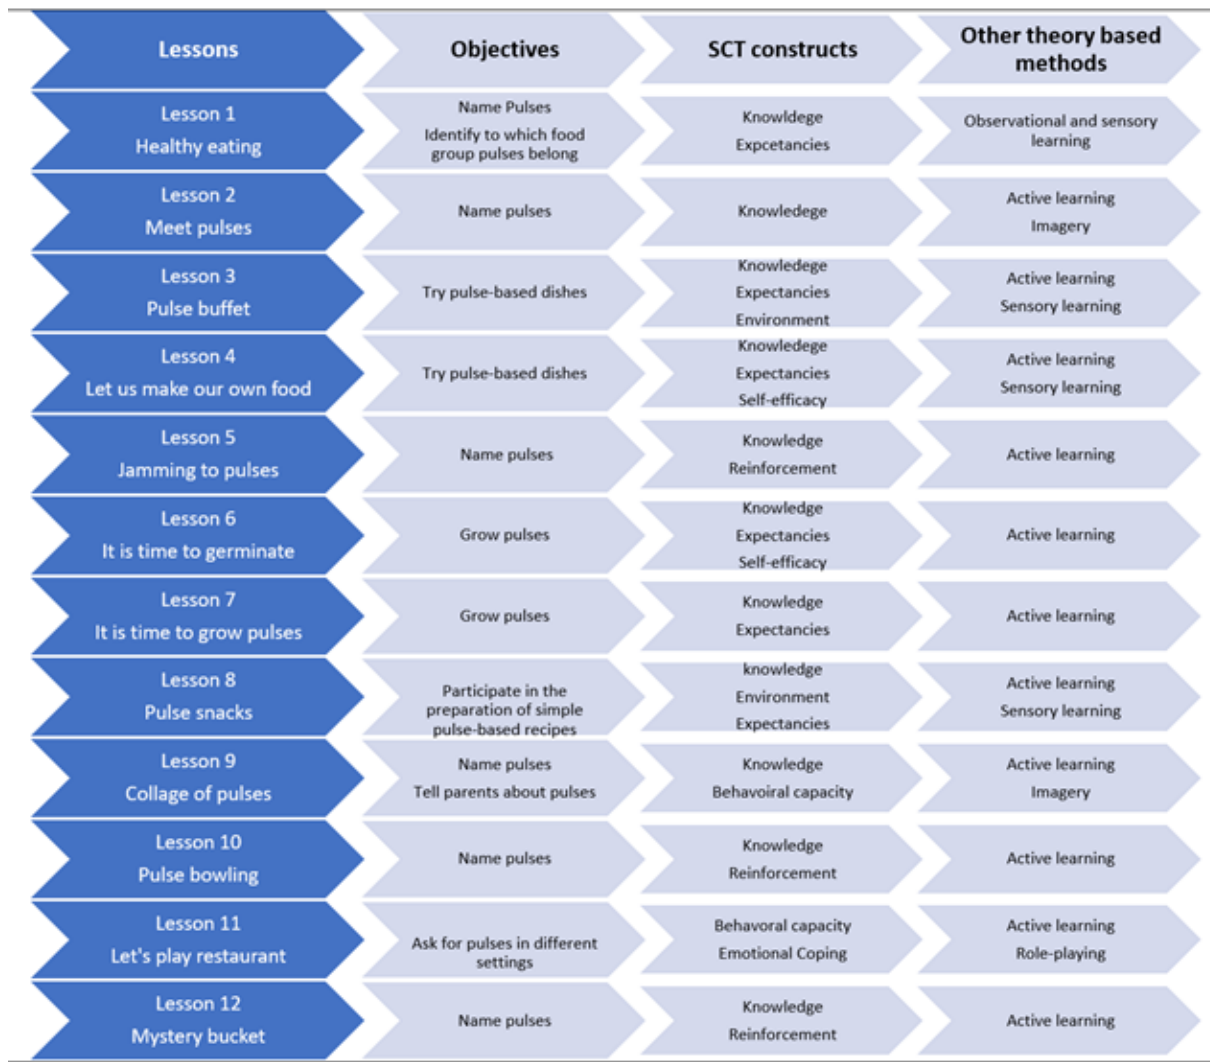
Figure 3. Matching the lesson plan activities of the Pulse Discovery Toolkit intervention with the social cognitive theory and other theory-based